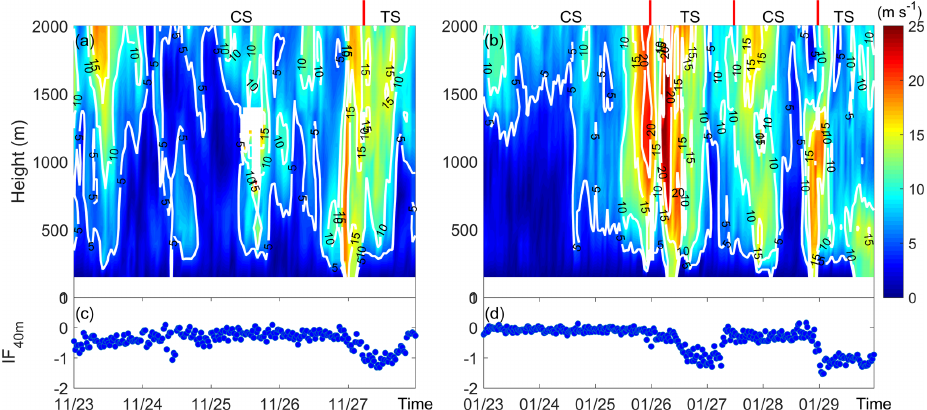
Figure 8. Height–time cross section of horizontal wind speed observed by the WPR for (a) Case-1 and (b) Case-2. Panels (c, d) present the corresponding IF at